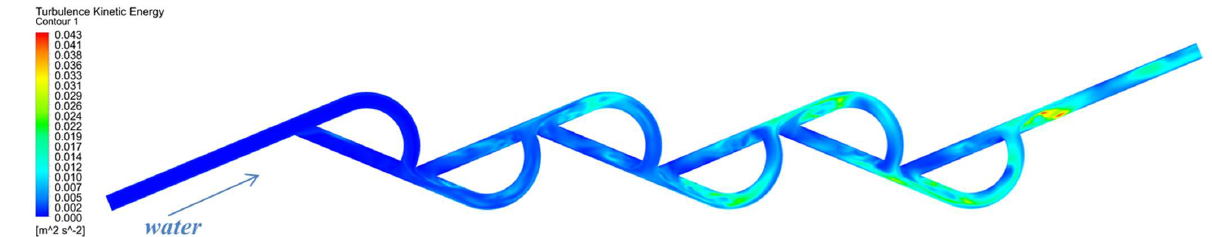
Figure 12. Cloud diagram of turbulent kinetic energy distribution.